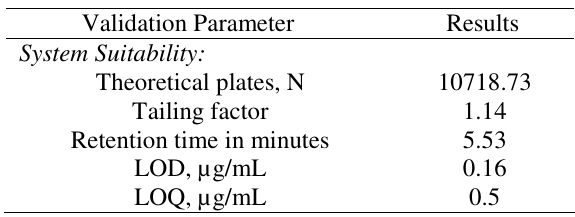
Table 3 . Validation